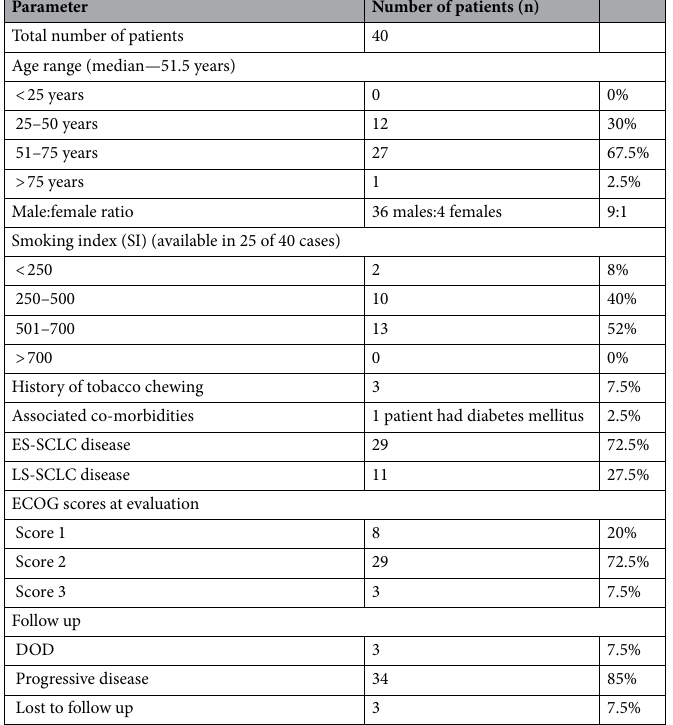
Table 1. Details of clinical characteristics of SCLC patients. DOD died of disease, ECOG Eastern Co-operative Oncology Group-performance status scale, ES-SCLC extensive stage small cell lung cancer, LS-SCLC limited stage small cell lung